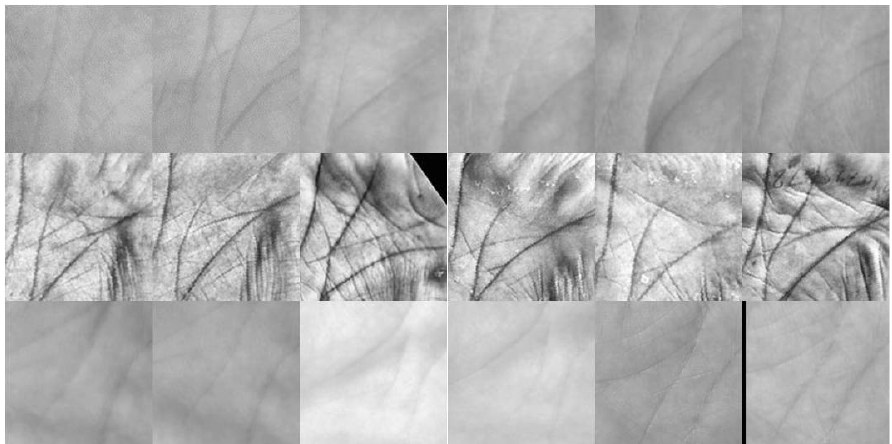
Figure 5. The typical palmprint image samples selected from the CASIA, IITD and GPDS databases, respectively, corresponding to the first to third